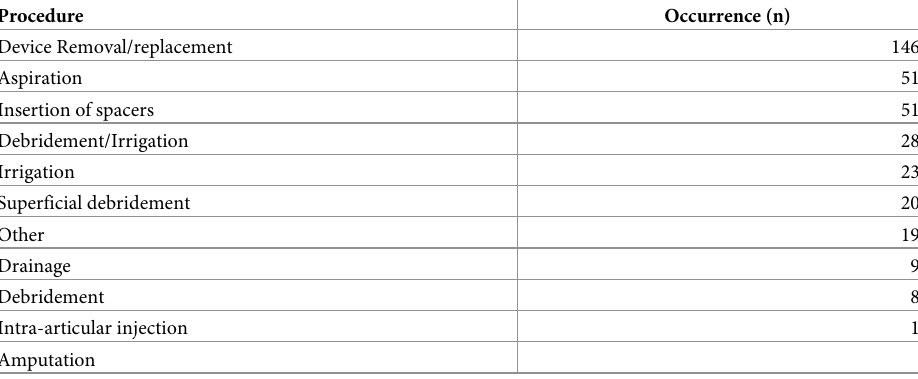
Table 5. Summary of procedures reported following PJI.